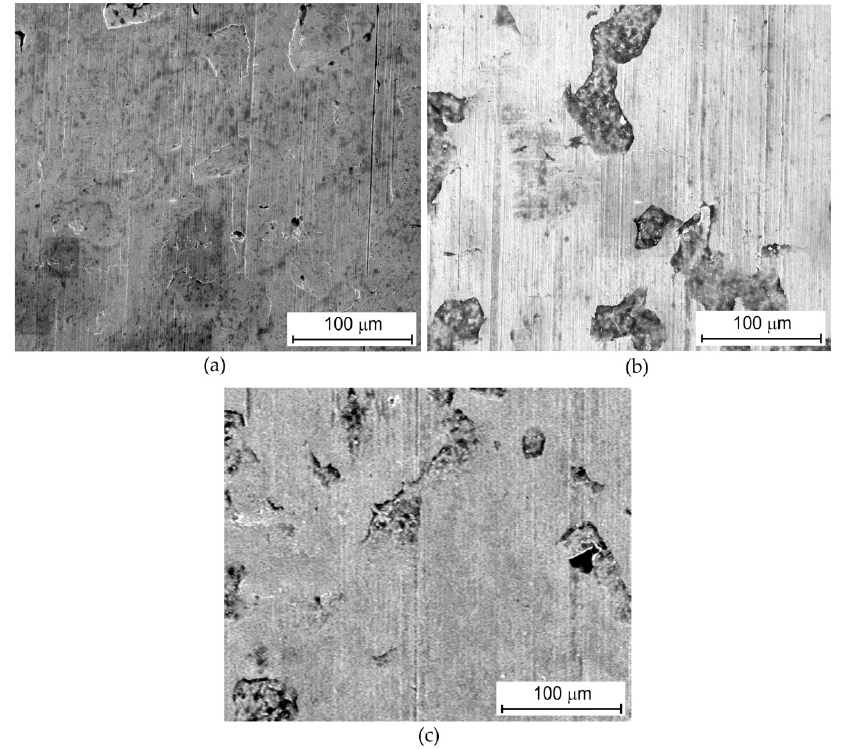
Figure 5. SEM micrographs of the sheet surface after friction tests carried out under following conditions: ( a ) dry friction, Ra = 0.32 μ m, nominal pressure p H = 30 MPa (magnification × 800); ( b ) olive, Ra = 0.32 μ m, p H = 30 MPa (magnification × 800) and ( c ) palm + BA, Ra = 0.32 μ m, p H = 30 MPa (magnification × 800).